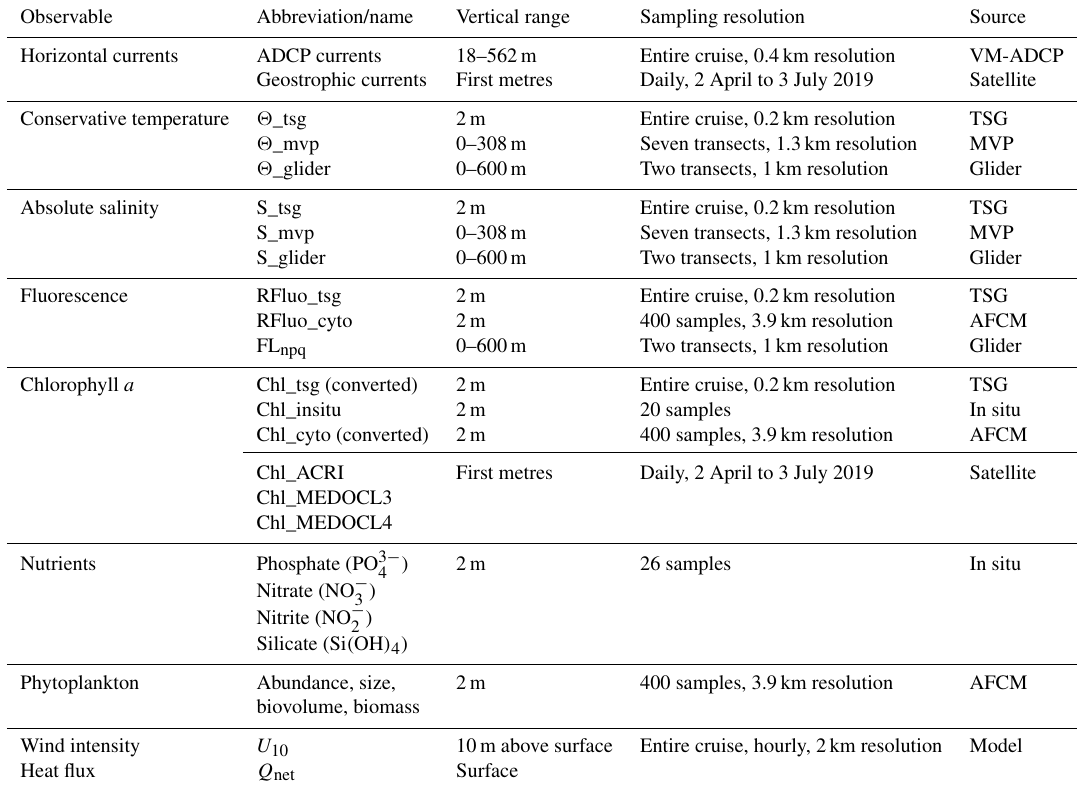
Table 1. Summary of the variables measured during the cruise, including their sources, their sampling spatial and temporal resolution, and the vertical range along which they were